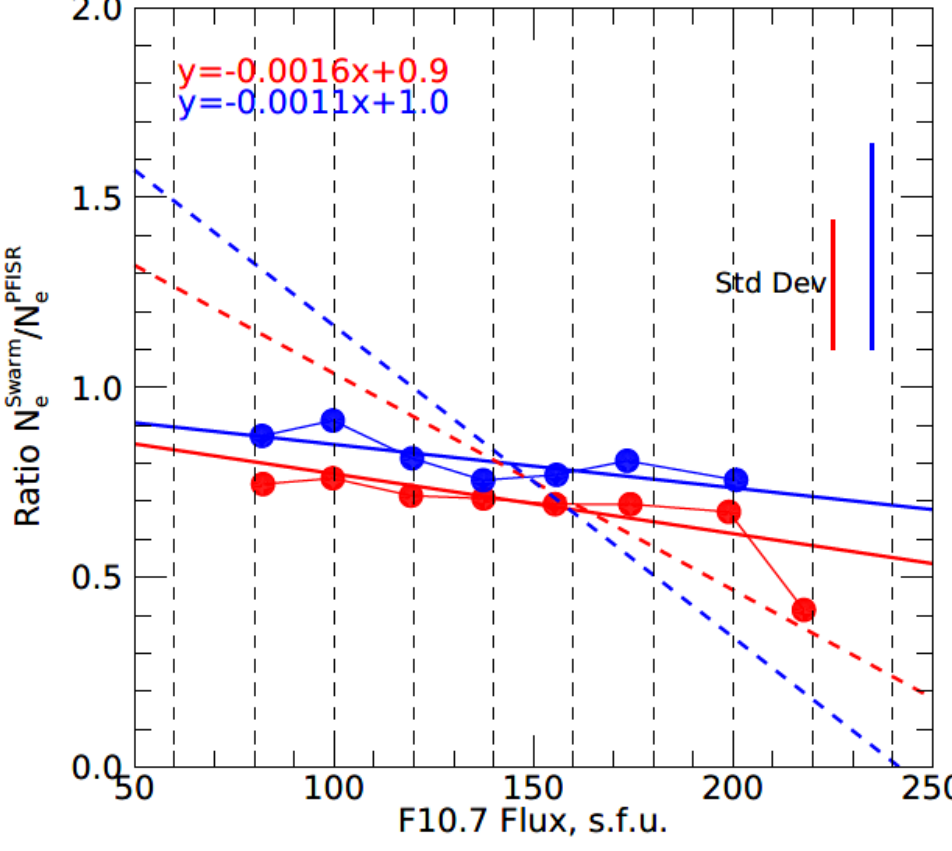
Figure 7. Medians of the ratio R = N eSwarm /N ePFISR as a function of the F10.7 cm radio flux (given in s.f.u. units) for joint PFISR–Swarm measurements in 2014–2016. Red and blue colors characterize PFISR conjunctions with Swarm AC and Swarm B, respectively. Bins of the F10.7 cm radio flux have a step of 20 s.f.u. Typical standard deviations for R over all flux bins are shown by vertical lines, on the right. Sloped solid lines are linear fits, and parameters of the fit are given in the top left corner. Sloped dashed lines are the linear fit lines as reported by Xiong et al. [33].